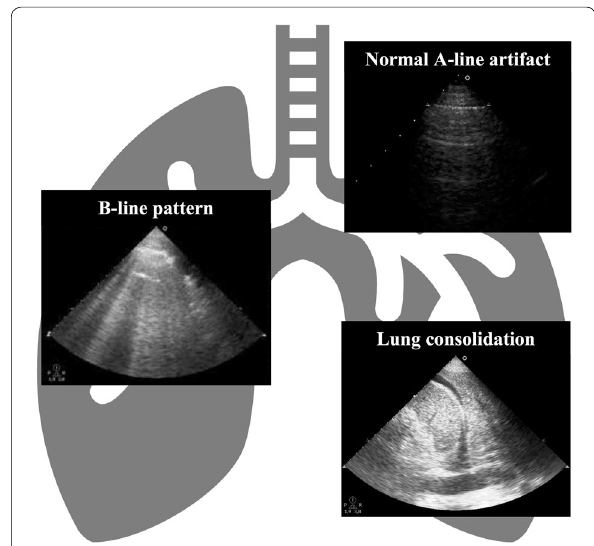
Fig. 1 Different echographic patterns during lung ultrasound